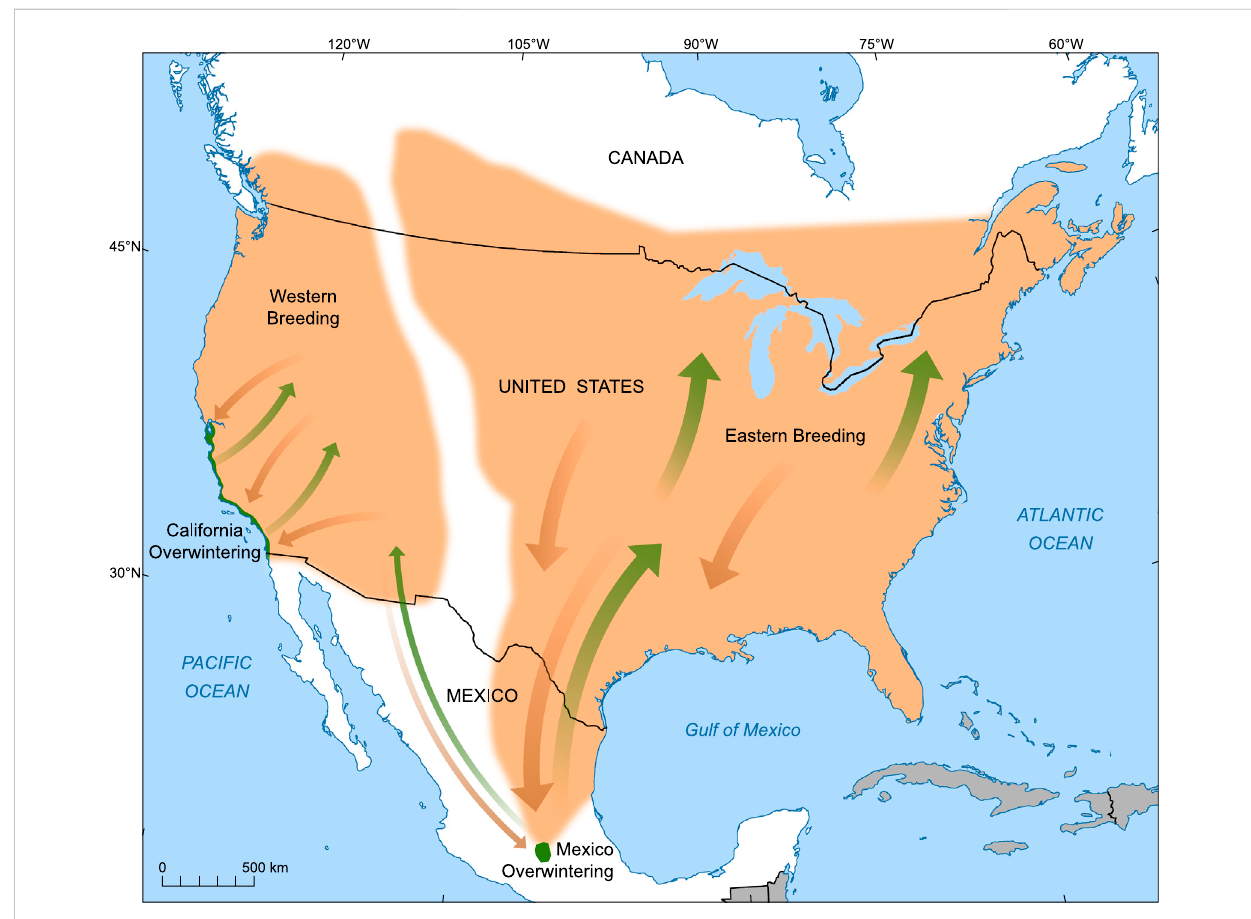
FIGURE 2 The generalized annual life cycle of monarch butter fl ies in North America. Dark green polygons represent areas of overwintering but the actual overwintering groves are much smaller. Green arrows represent spring migration, brown arrows represent fall migration.